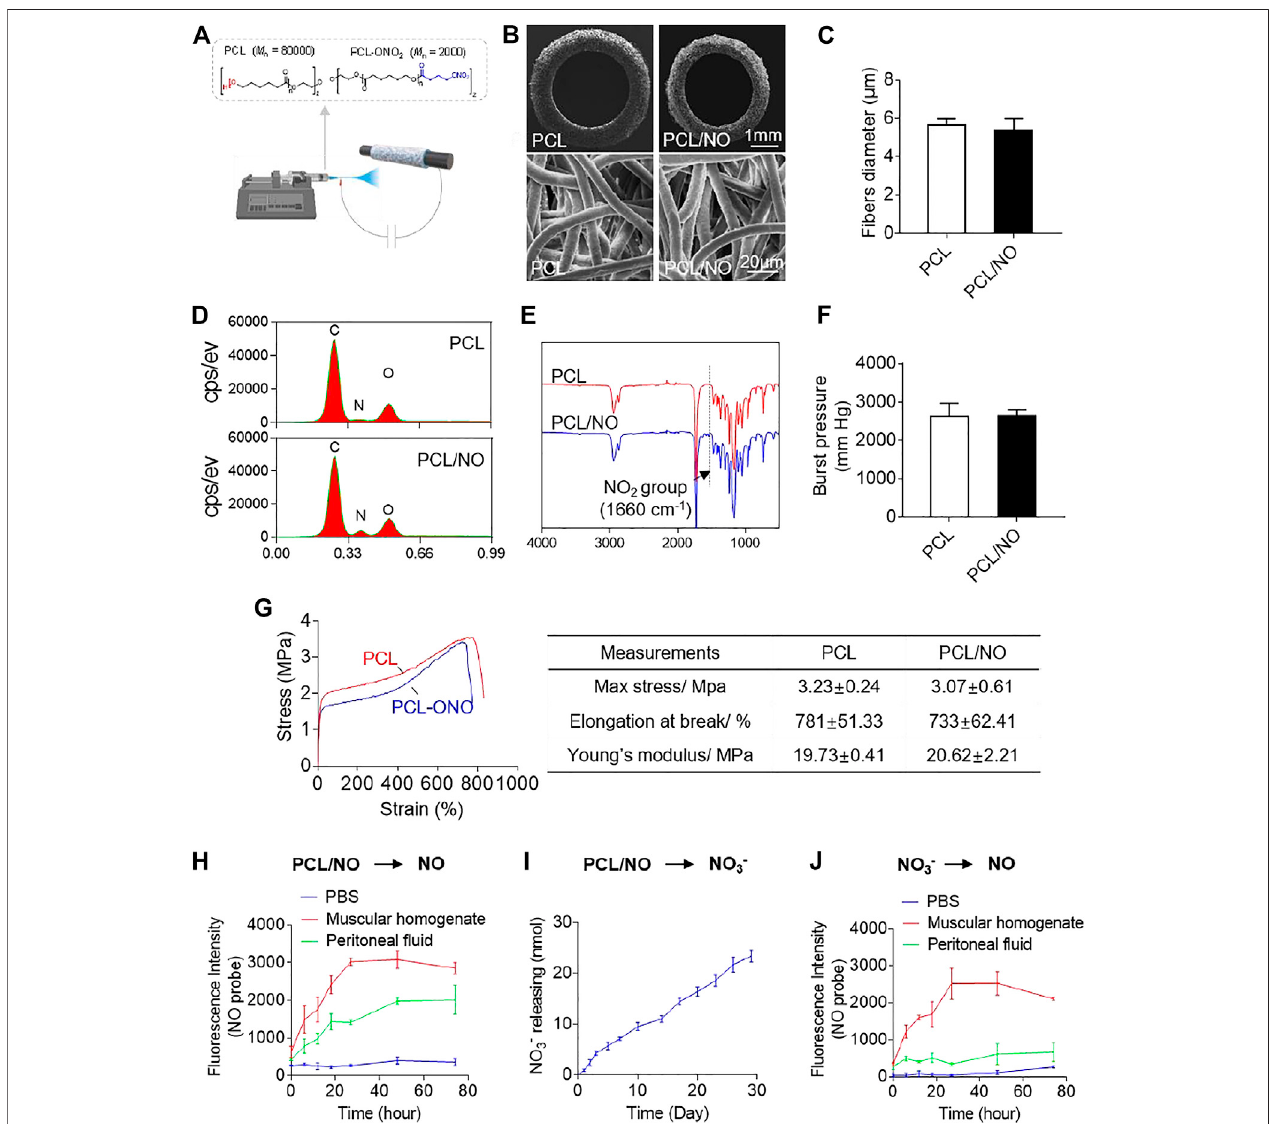
FIGURE 1 | Fabrication and characterization of nitrate-functionalized SDVGs. (A) Schematic illustrating the PCL/NO SDVG synthesis by electrospinning of PCL blends. (B) SEM images of SDVG enface cross-sections ( top row ; scale bar (cid:1) 1 mm) and surface networks of PCL micro fi bers ( bottom row ; scale bar (cid:1) 20 µm). (C) Average PCL micro fi ber diameter in PCL and PCL/NO SDVGs. (D) EDS analysis of the SDVGs demonstrating an elevated nitrogen-peak in PCL/NO. (E) FTIR analysis of the SDVGs demonstrating the presence of NO2 groups (1,660 cm-1) in PCL/NO grafts. (F) The burst pressure of the SDVGs. (G) Representative stress-strain curvesofthePCLandPCL/NOvasculargraftsandthequantitativeanalysisofmechanicalpropertiesshowninthetablealongside.Datapresentedasmean ± S.E.M. (H) NO generation from PCL/NO in the presence of muscular homogenate (20 mg/ml) or peritoneal fl uid was detected by DAF-FM in vitro . (I) The long-term and slow accumulativereleaseofnitrateandnitriteionsfromSDVGsover30 daysinPBSbuffer. (J) ReductionofNO3 − intoNOinthepresenceofmuscularhomogenate(20 mg/ ml) or peritoneal fl uid. Images and data are representative of n (cid:1) 3 independent experiments.